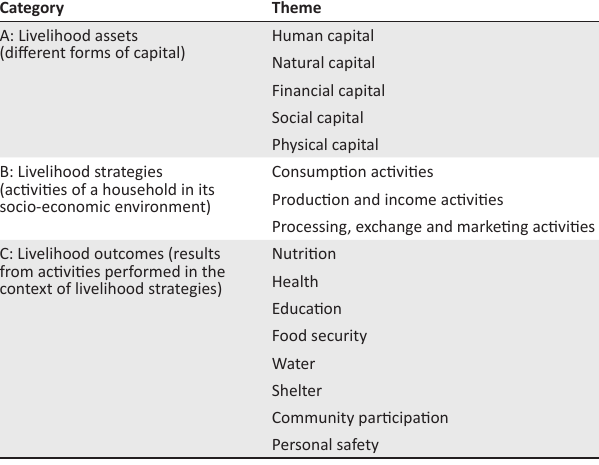
TABLE 1: Categories and main themes used to analyse the data collected.